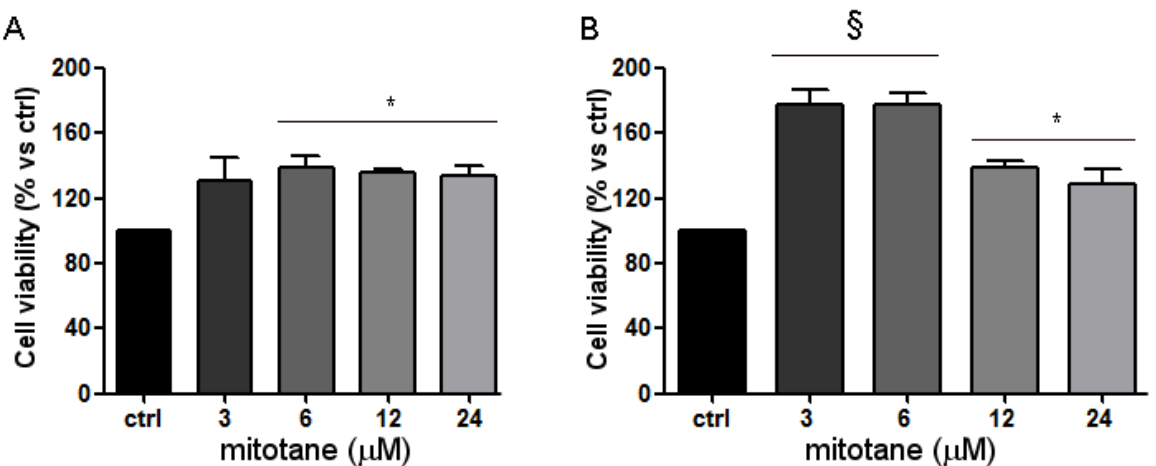
Figure 3. Effect of mitotane on MCF-7 cell viability and proliferation. ER- α -positive MCF-7 cell line was treated with increasing concentrations of mitotane as described in Methods: ( A ) cell viability was measured by MTT assay. Data are expressed as percentage vs. untreated cells ± SEM. * p < 0.05; ( B ) cell proliferation rate was estimated by direct count, with trypan blue discrimination. § p < 0.0001 vs. untreated cells; * p < 0.01 vs. untreated cells. Data are expressed as percentage vs. untreated cells ± SEM. Results are the mean of three independent experiments run in triplicate.